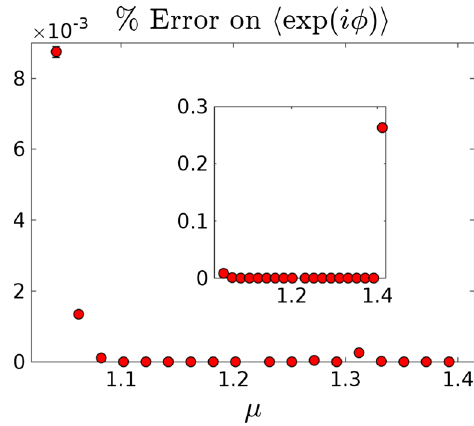
Table 2 Logarithm of the phase factor expectation value from [16] and comparison with the telegraphic approximation presented in the text. ( (cid:3) is the deviation for the logarithm of the phase, (cid:3) = ln (cid:2) e i φ (cid:3) exact